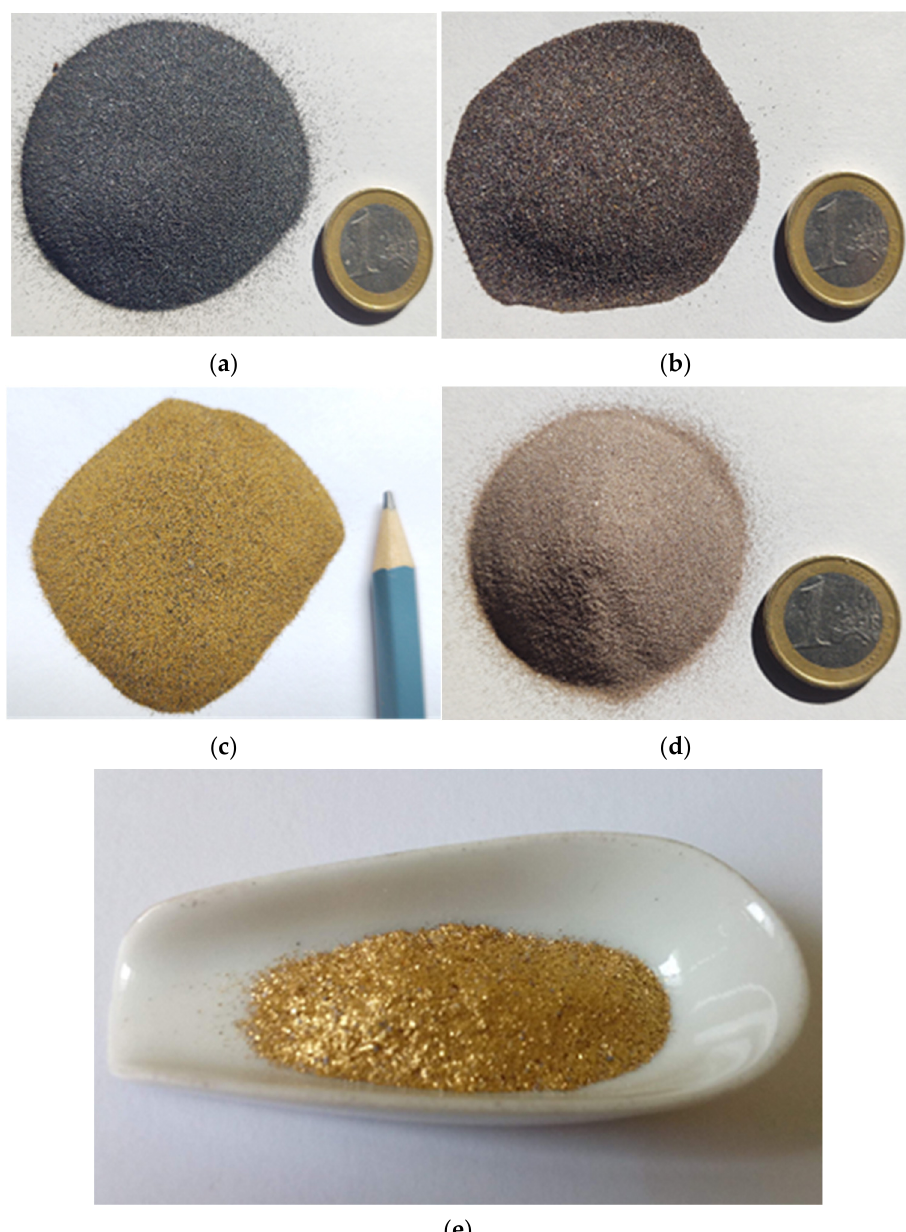
Figure 6. Photos of the prepared concentrates: ( a ) ilmenite, ( b ) rutile, ( c ) monazite, ( d ) zircon, ( e ) gold.